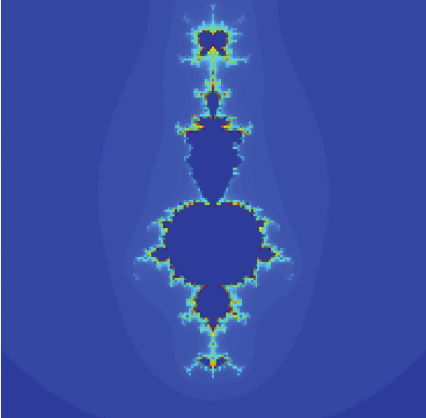
for the critical point 3